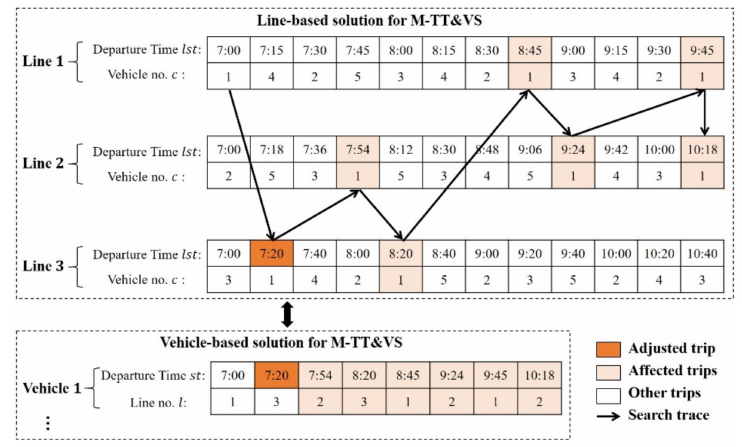
Figure 4. An example for the search trace with different solution structures.